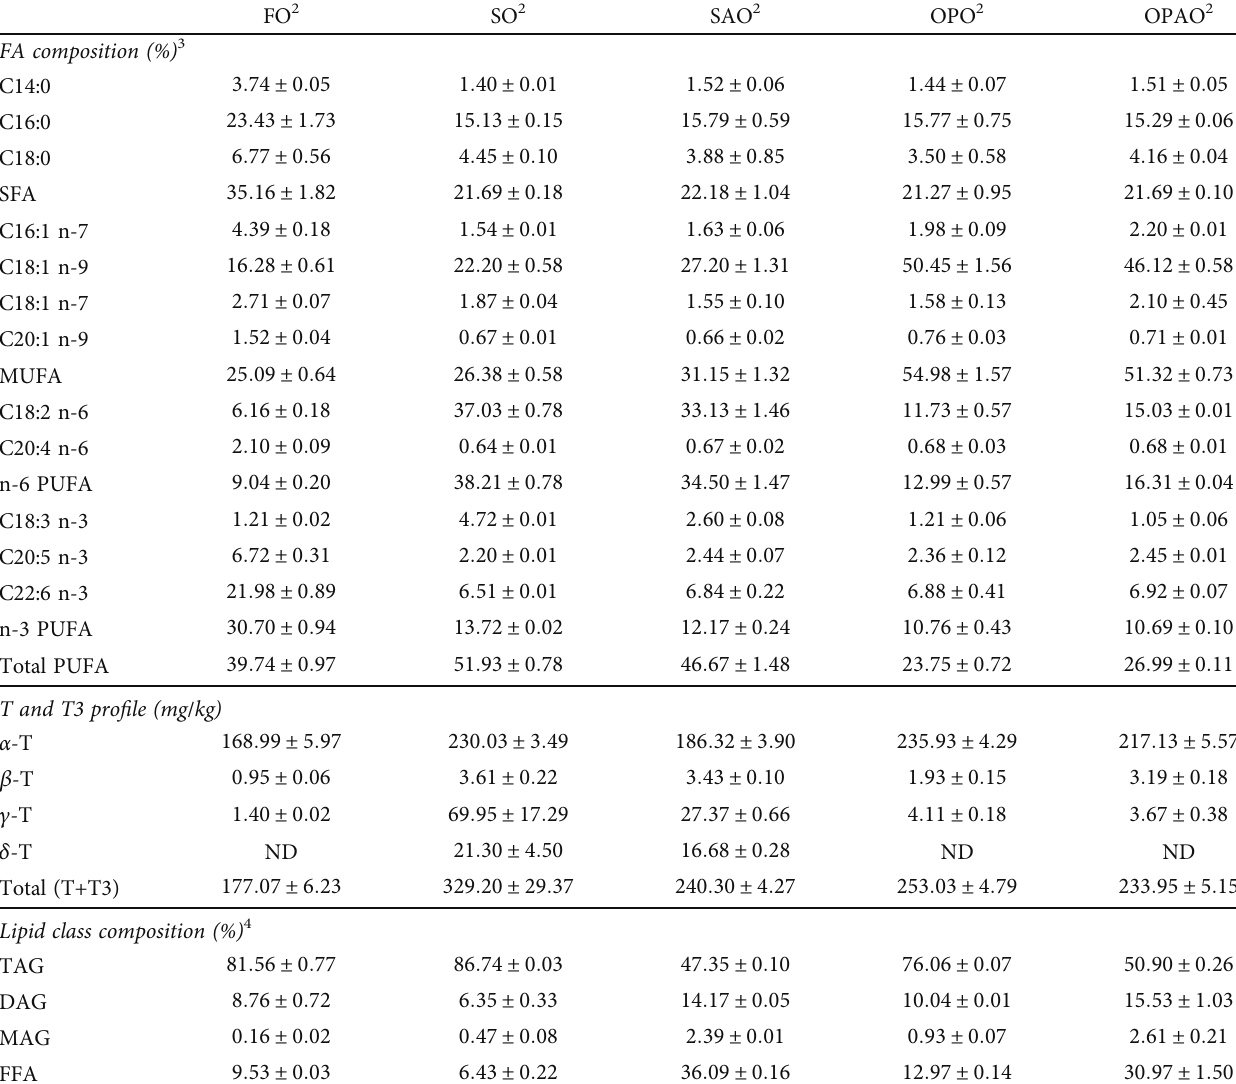
Abbreviations: For diet abbreviations (FO, SO, SAO, OPO, and OPAO), see Table 2; FA: fatty acid; SFA: saturated fatty acids (sum of C14:0, C15:0, C:16:0; C18:0, and C22:0); MUFA: monounsaturated fatty acids (sum of C16:1 n-9, C16:1 n-7, C18:1 n-9, C18:1 n-7, and C20:1 n-9); PUFA: polyunsaturated